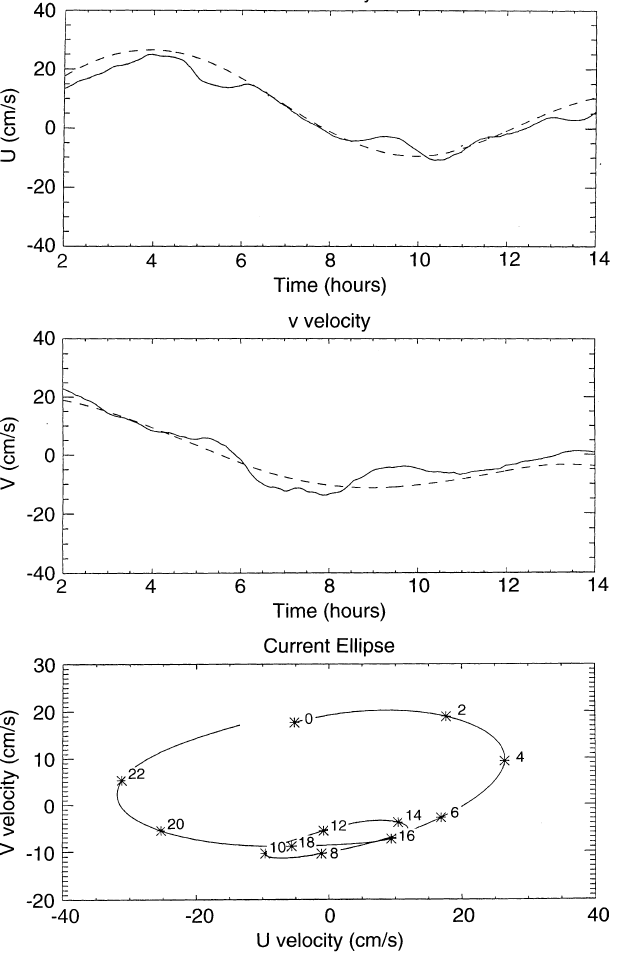
Fig. 6a–c. Barotropic tides on the 13th August 1996 in the survey region. a smoothed, depth averaged u velocity from ADCP in cm/s, and b corresponding v velocity in cm/s. The smoothing was done over 1 h. Overplotted as a dashed line is the prediction from the model of Small et al. (1998). c Tidal ellipse from the model for 13th August, with 2 hourly positions